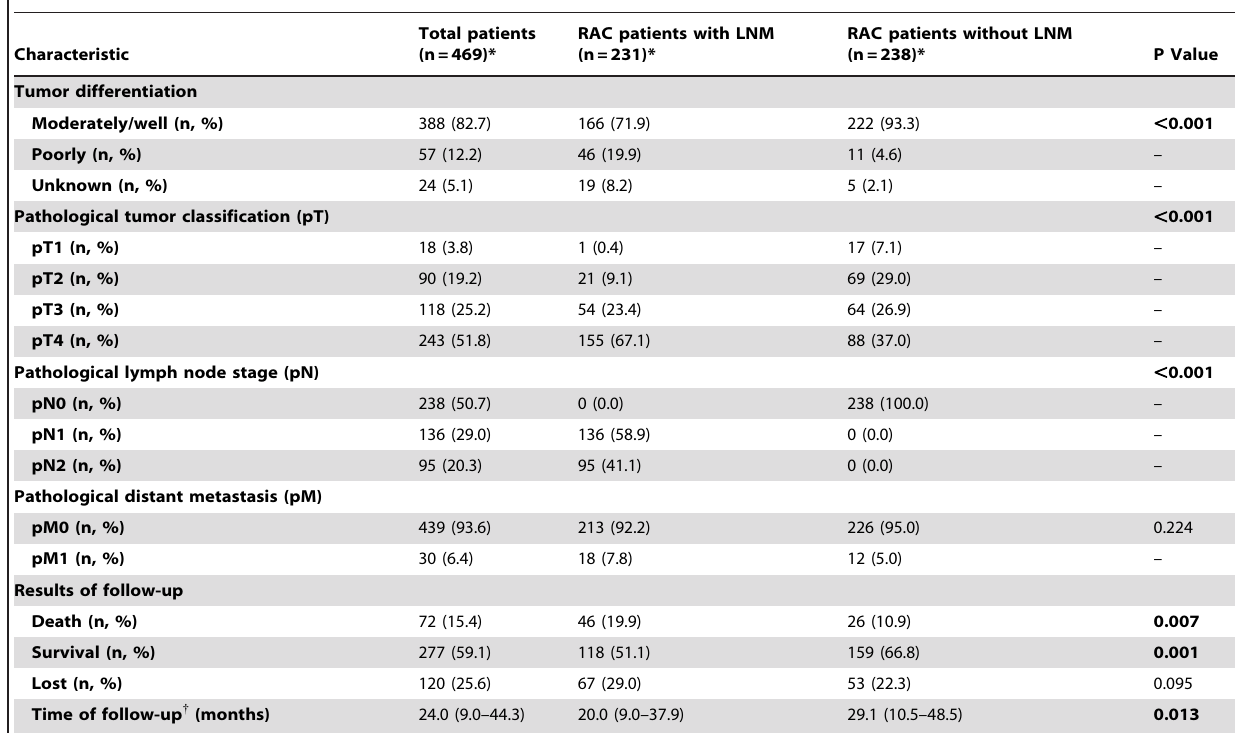
Table 2. Pathological characteristics and follow-up results of 469 RAC patients.